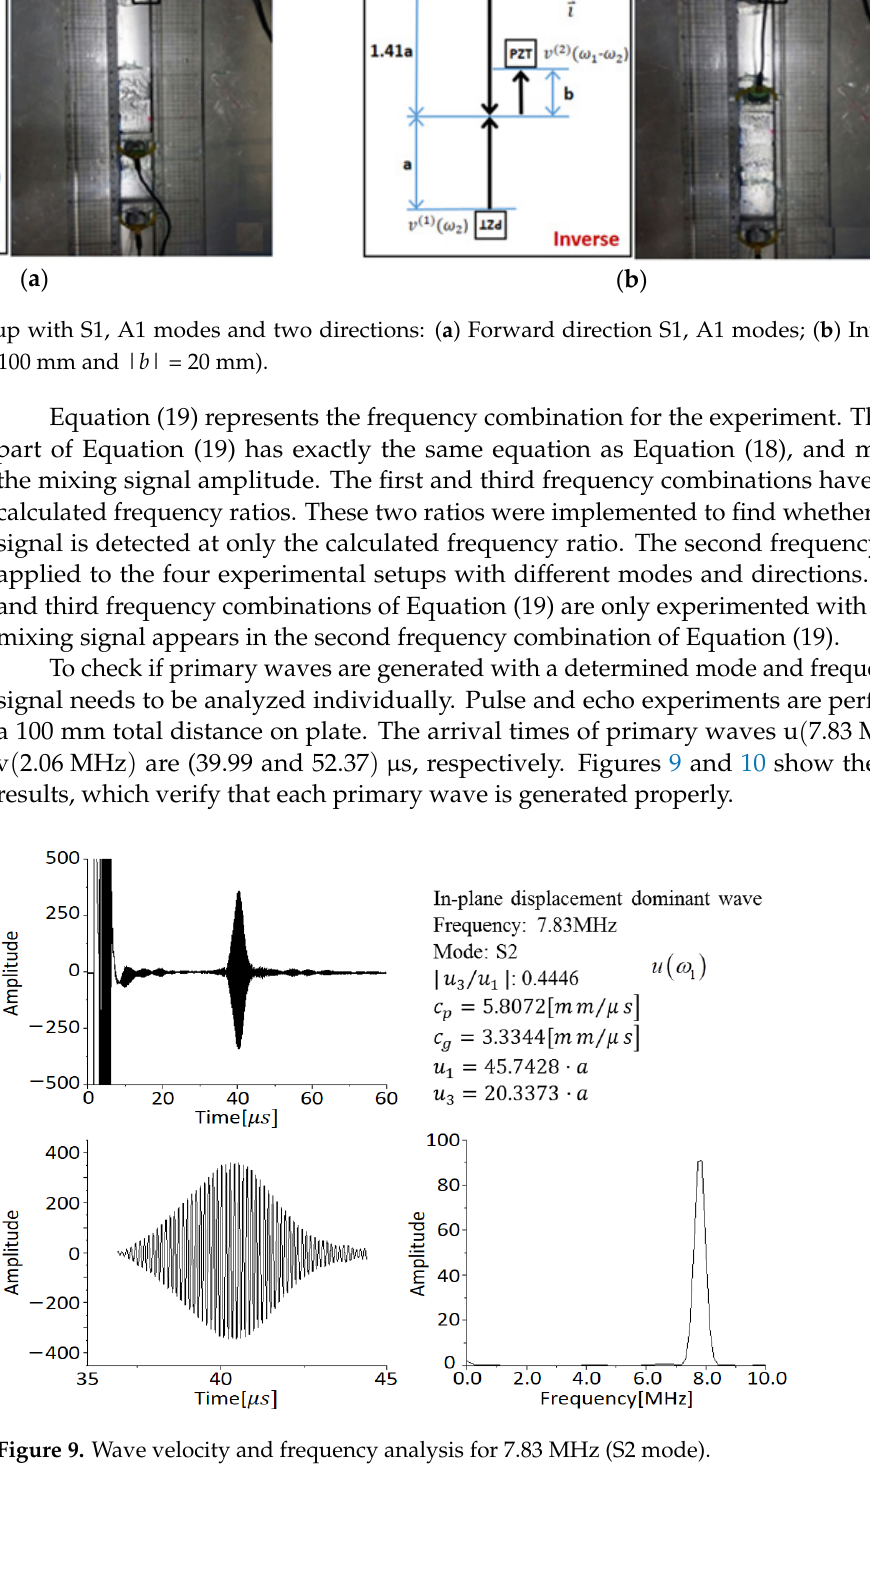
Figure 8. Experimental setup with S1, A1 modes and two directions: ( a ) Forward direction S1, A1 modes; ( b ) Inverse direction S1, A1 modes ( a = 100 mm and | b | = 20 mm).